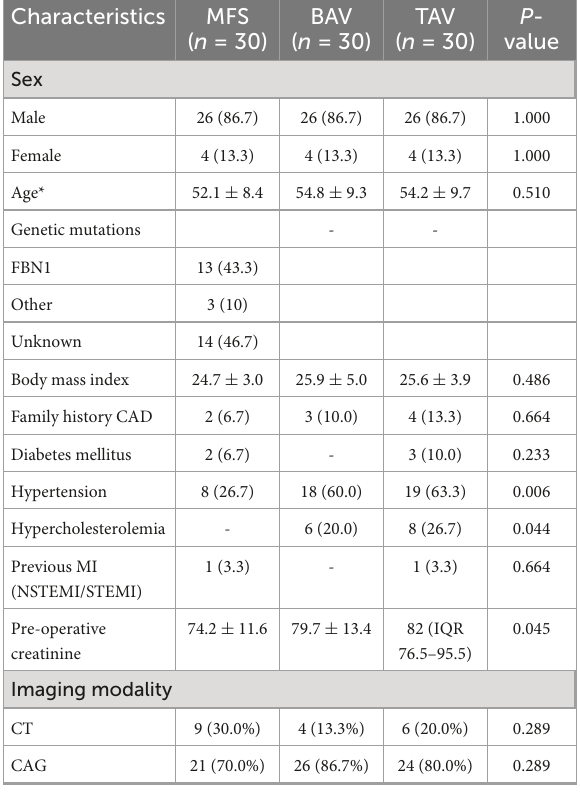
TABLE 1 Baseline